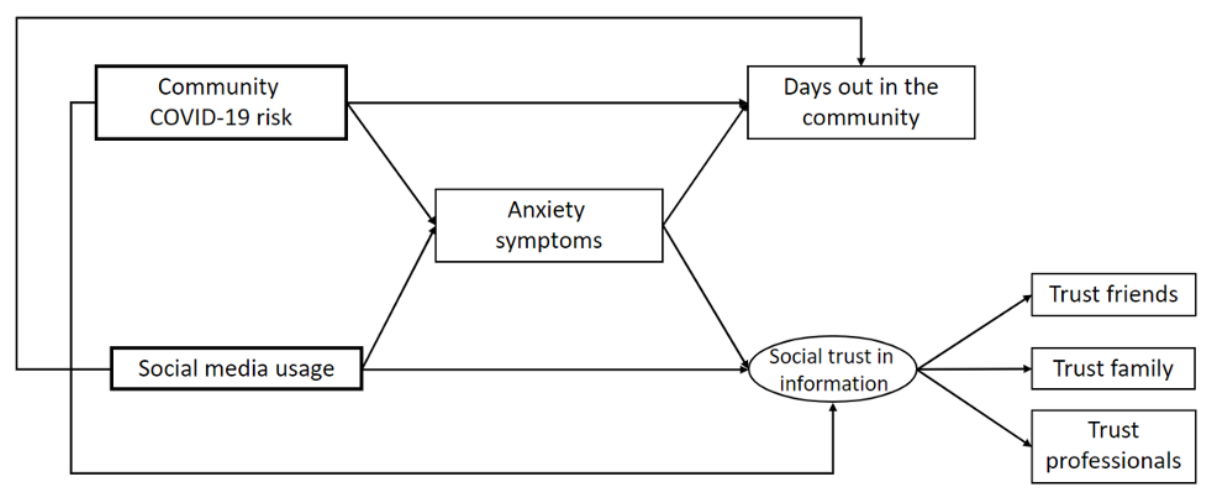
Figure 1. Theoretical